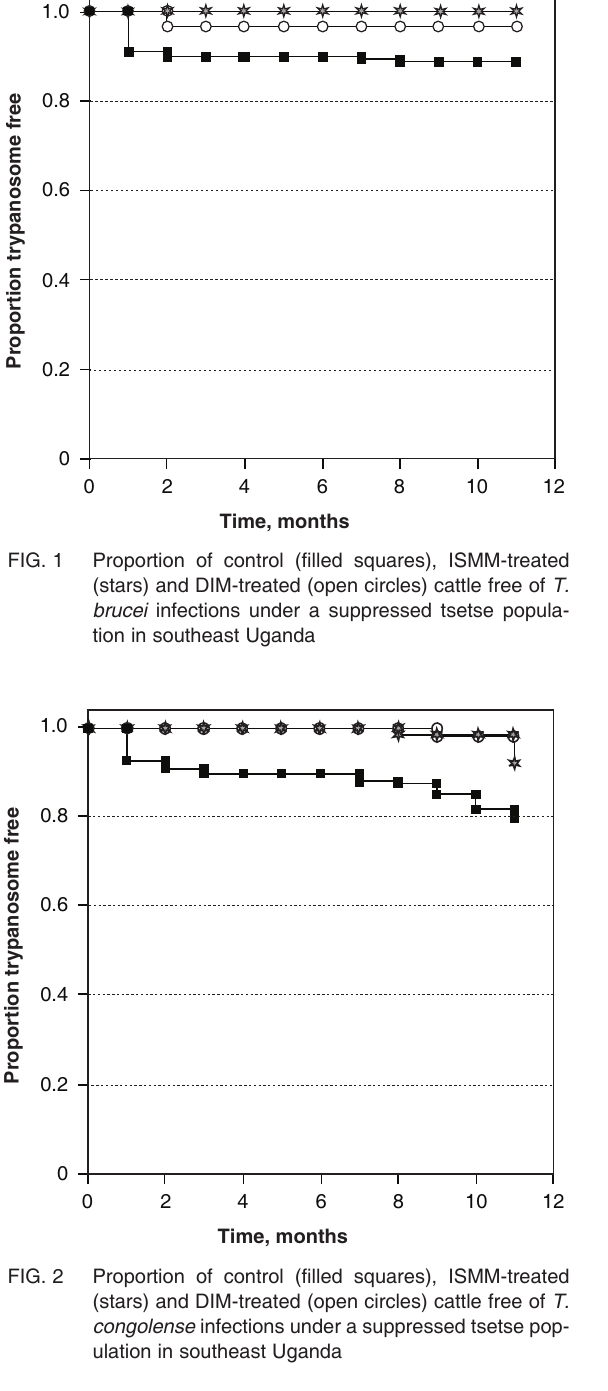
longer for treated animals than controls (χ 2 = 205.6, d.f. = 1, P < 0.01). 1, P < 0.01).